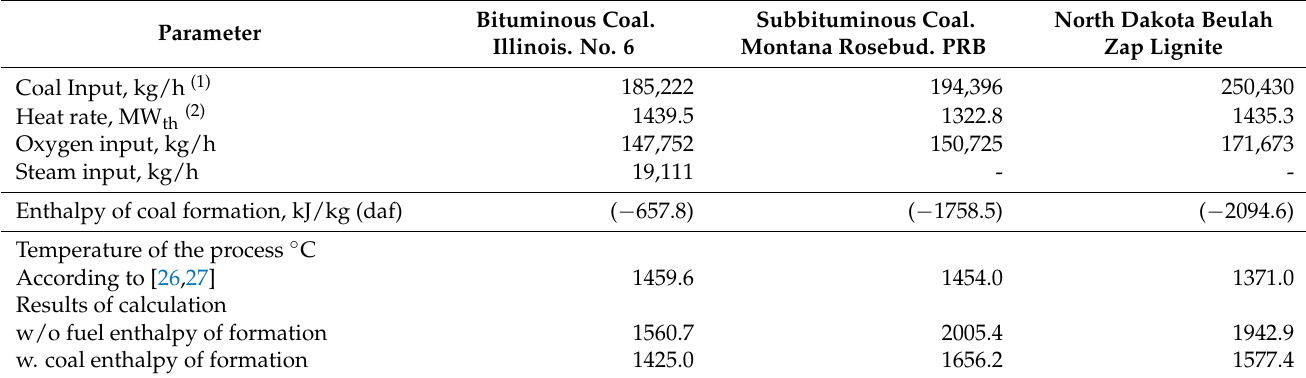
Table 5. Process parameters and results of calculation